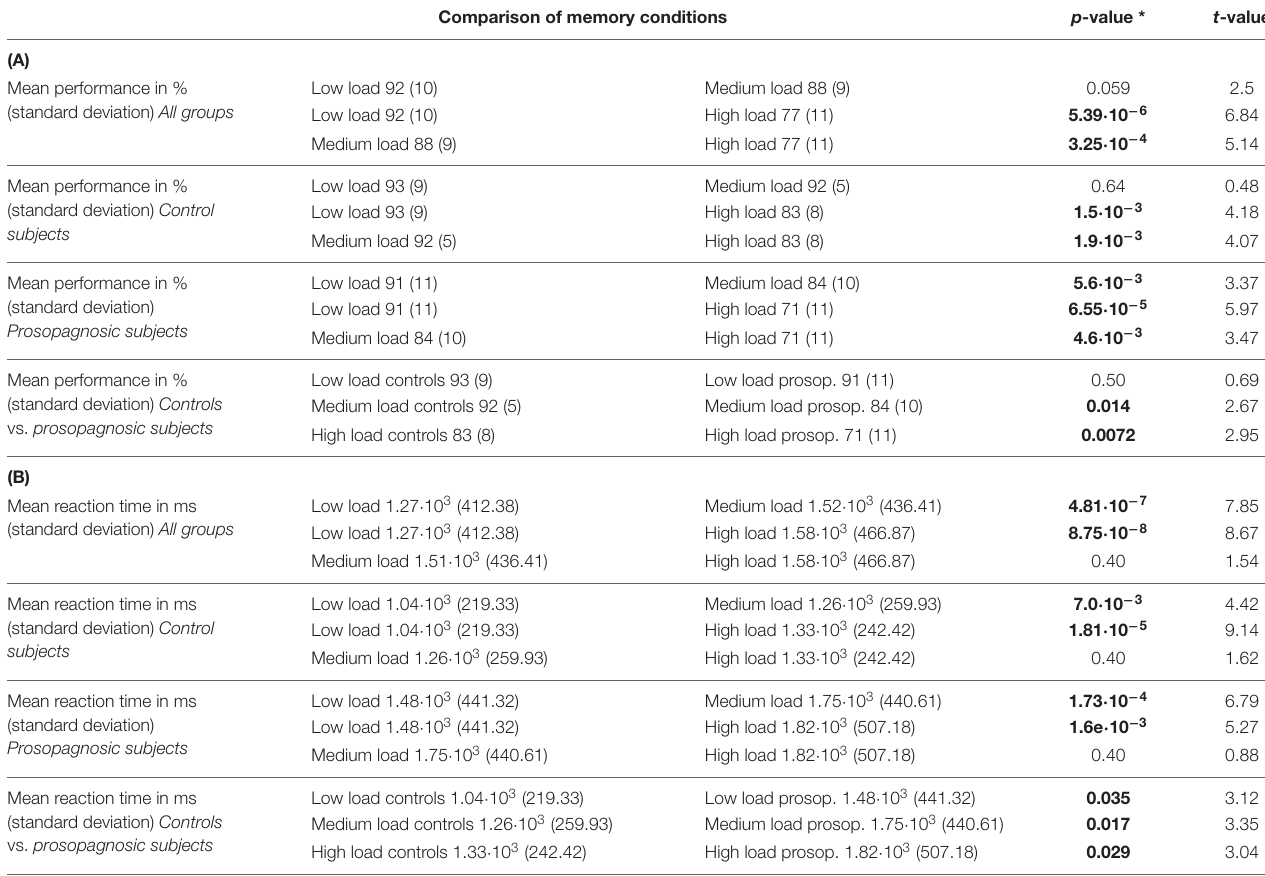
TABLE 1 | Overview of the statistical comparisons via Student’s t -test with Bonferroni-Holm-correction for the different memory conditions and groups. Comparison of memory